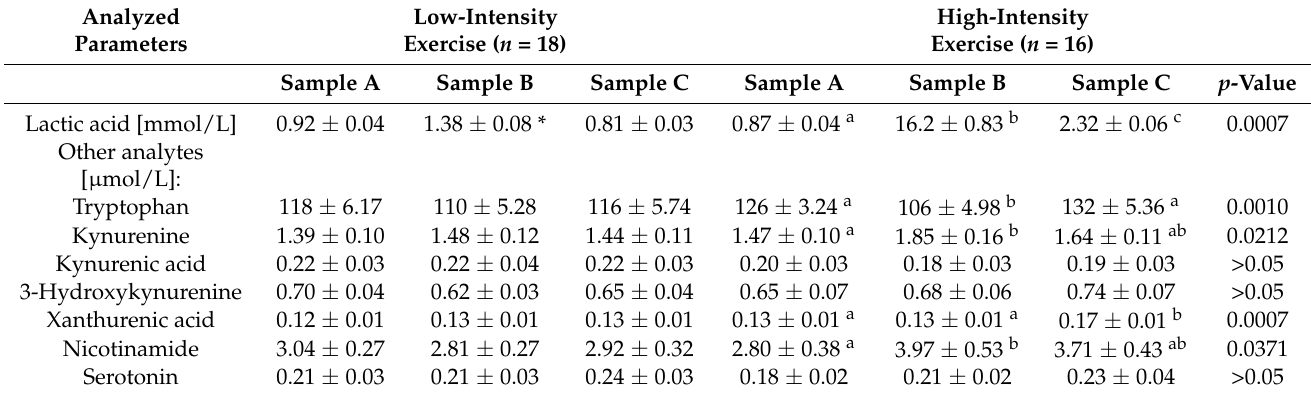
Table 1. Plasma tryptophan and its metabolites determined in trained racehorses during the exercise of different intensities (means ±